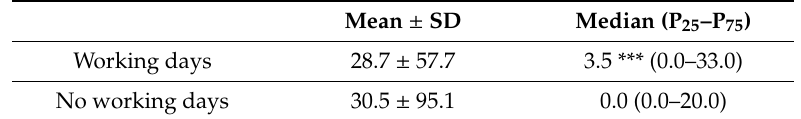
Table 4. Household and out-of-home plate waste (PW. g / d) by week schedule amongst the ANIBES study population.